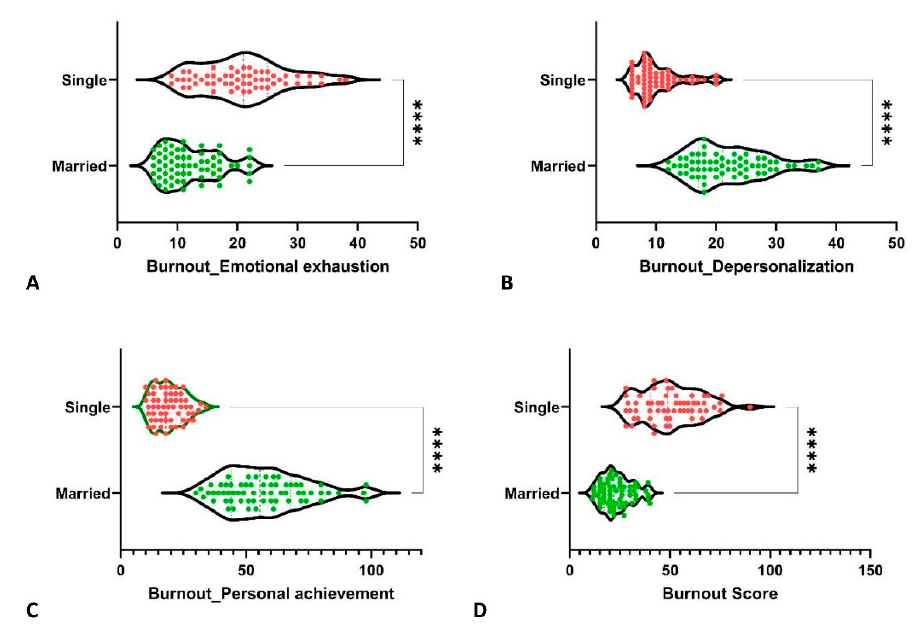
Figure 3. Burnout comparison between married and single participants. ****, p -value < 0.0001.